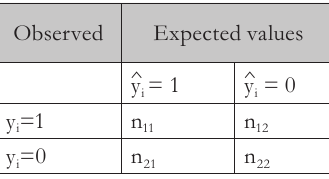
Tab. 2 – The accuracy of cases classification. Source: Machowska-Szewczyk & Sompolska- Rzechuła,